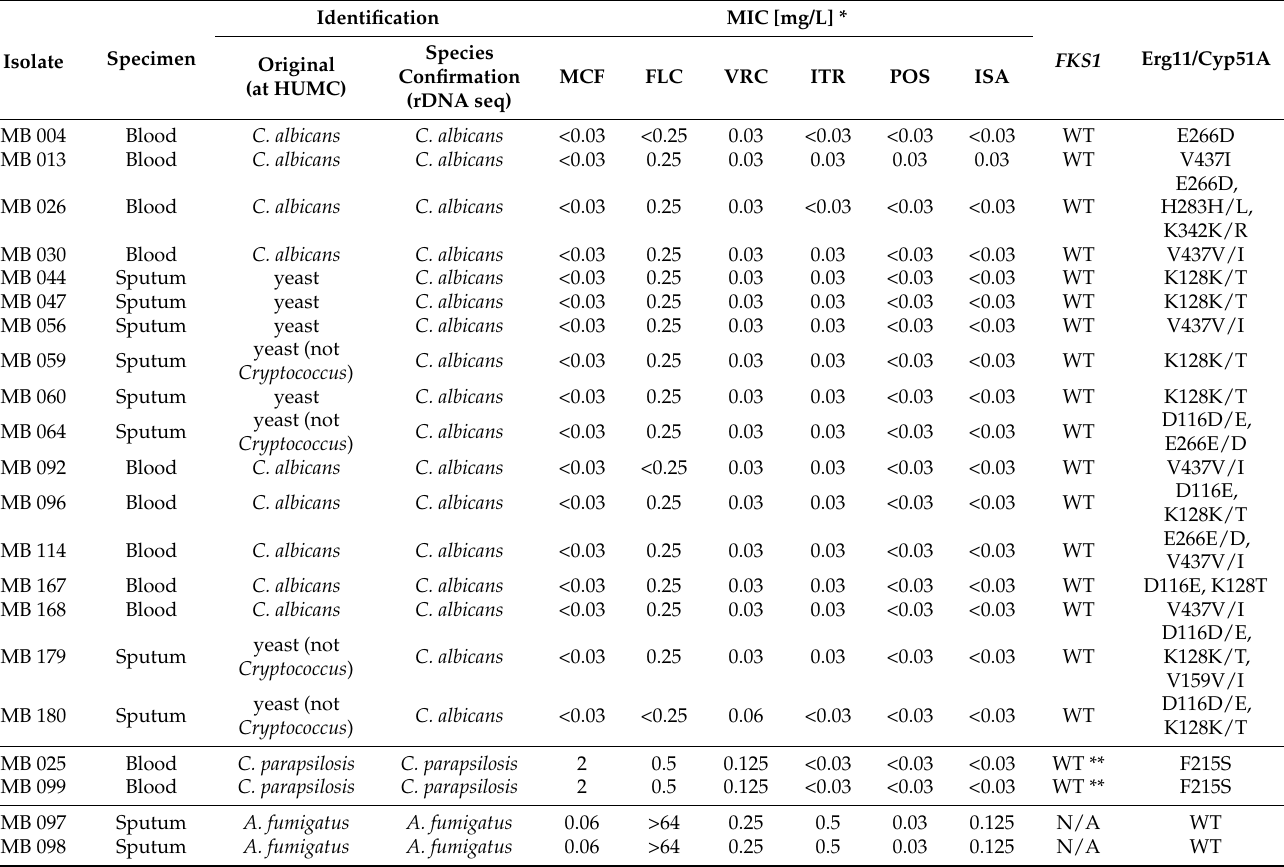
Table 1. Results of identification, antifungal susceptibility testing, and antifungal drug target sequencing for fungal isolates recovered from COVID-19